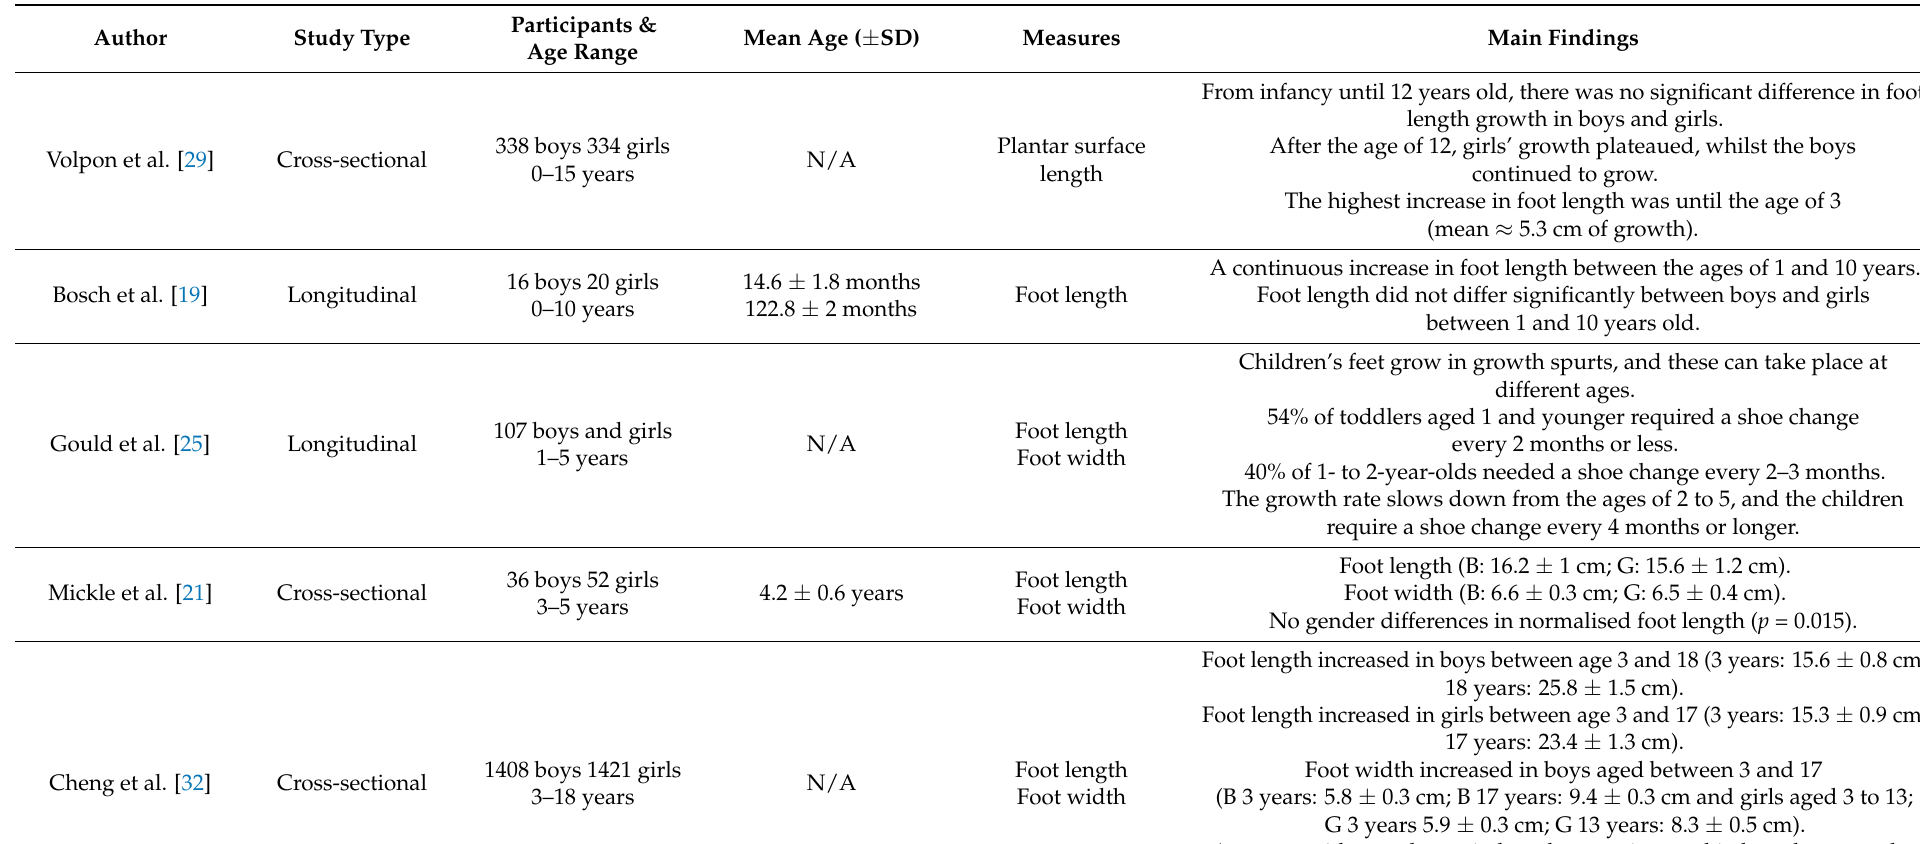
Table 1. A summary of the studies examined relating to the development of foot length and